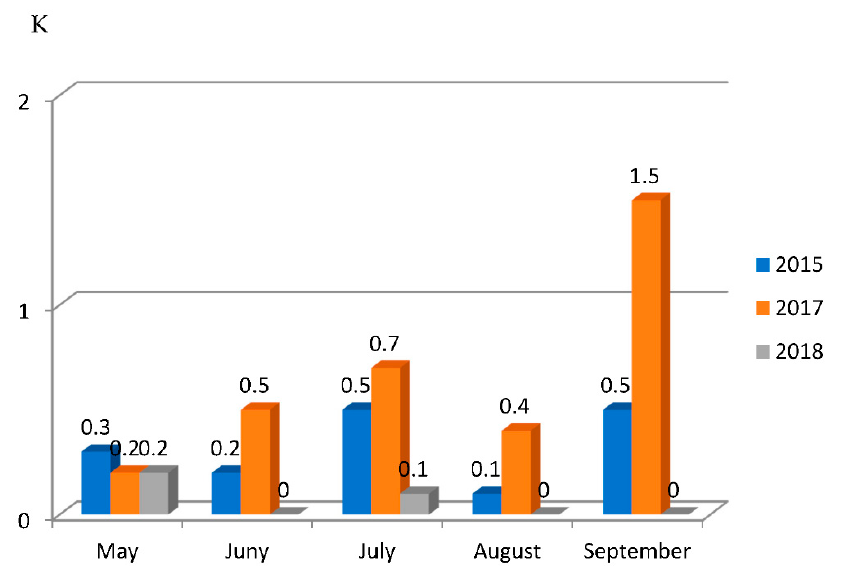
Figure 3. The Selyaninov’s hydrothermal coefficient in months and years of the study (K < 1.0—drought; K = 1.0–2.0—moist; K > 2.01—wet). Table 6. Mean cloud cover during the growing season of tomatillos according to the Institute of